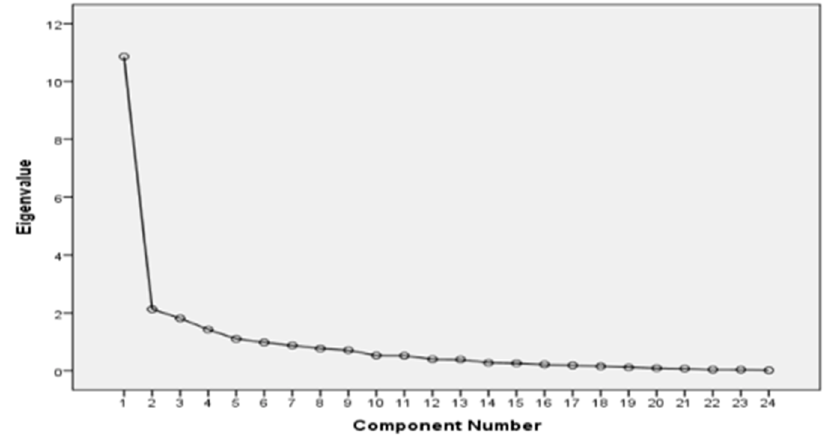
Figure 1. Scree Plot. Table 4. Total Variance Explained.